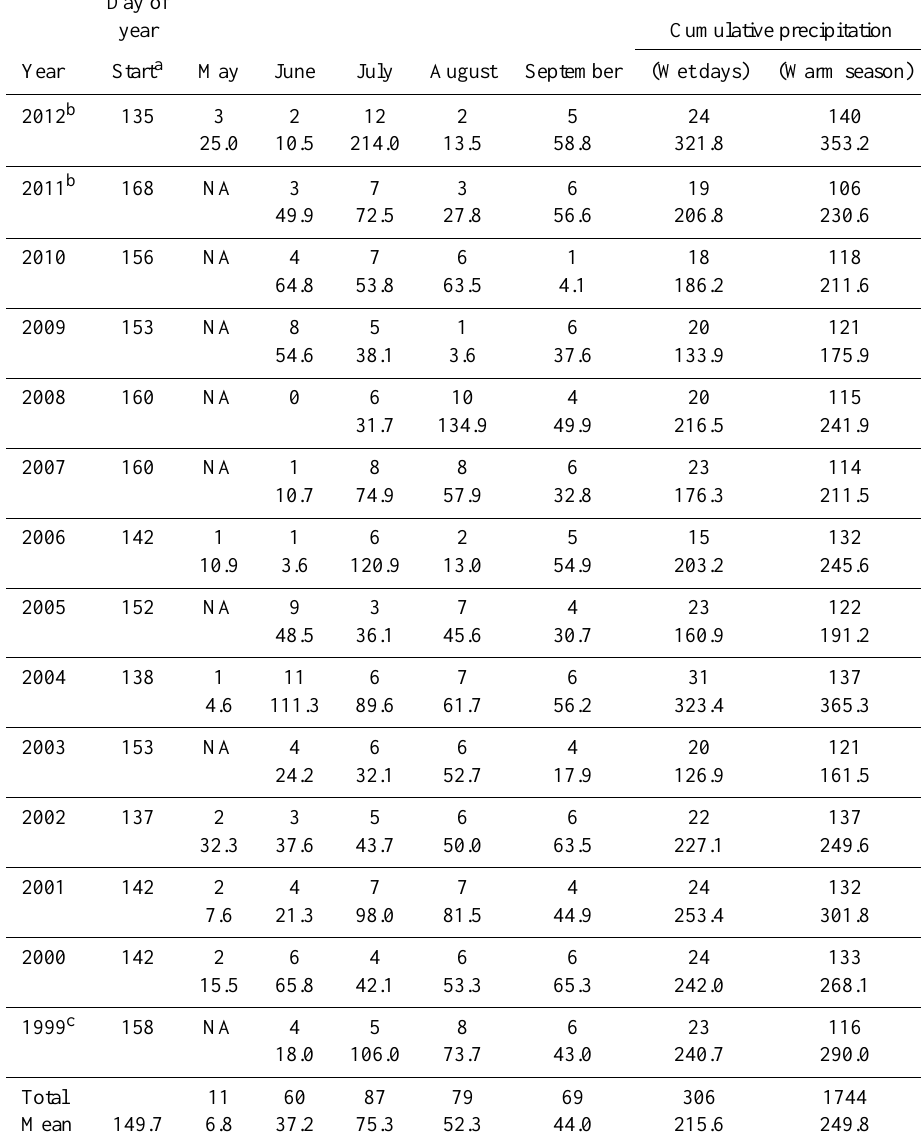
Table 1. Precipitation statistics for the US-NR1 AmeriFlux site. The number of days with a daily precipitation greater than 3mmday − 1 for each year and month is shown. These are defined as “wet” days in the analysis (see text for details). If the warm season started in June, then the May column is filled with “NA”. The total cumulative precipitation from the wet days is given immediately below the number of days. In the two right-hand columns the cumulative precipitation from the wet days only and from all days within the warm season are provided. Precipitation units are